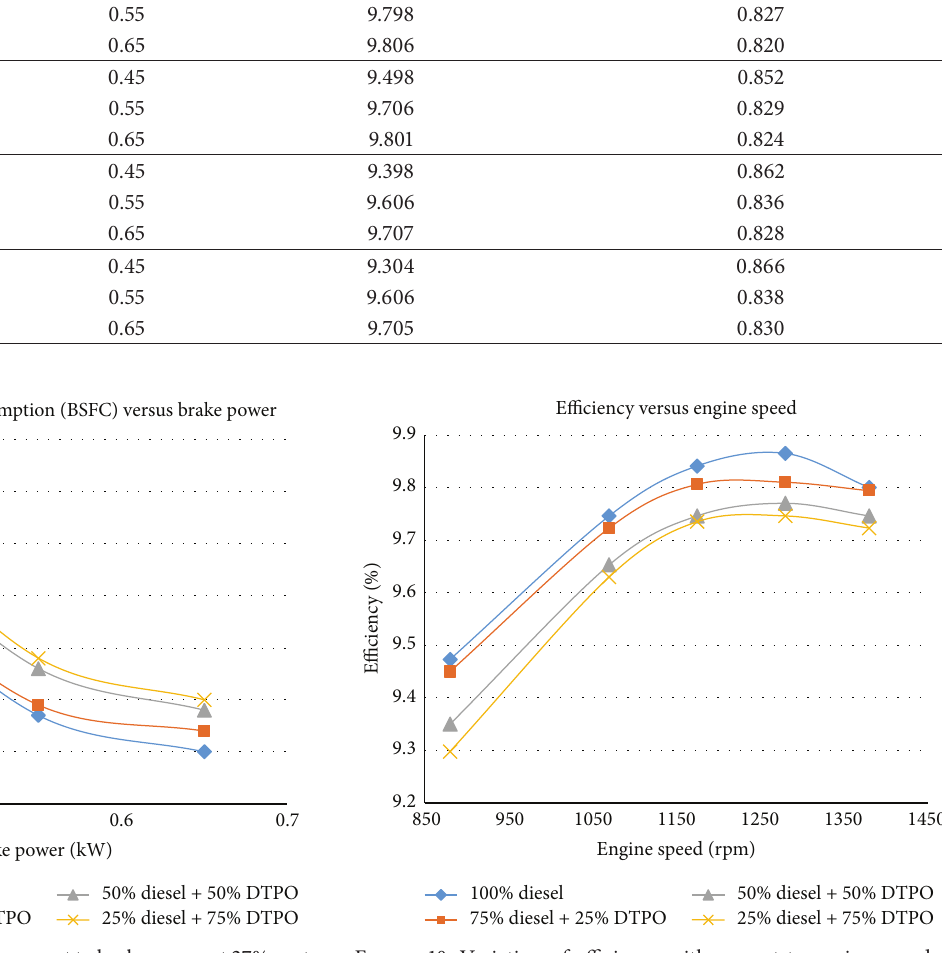
Figure 10: Variation of efficiency with respect to engine speed at 27% part